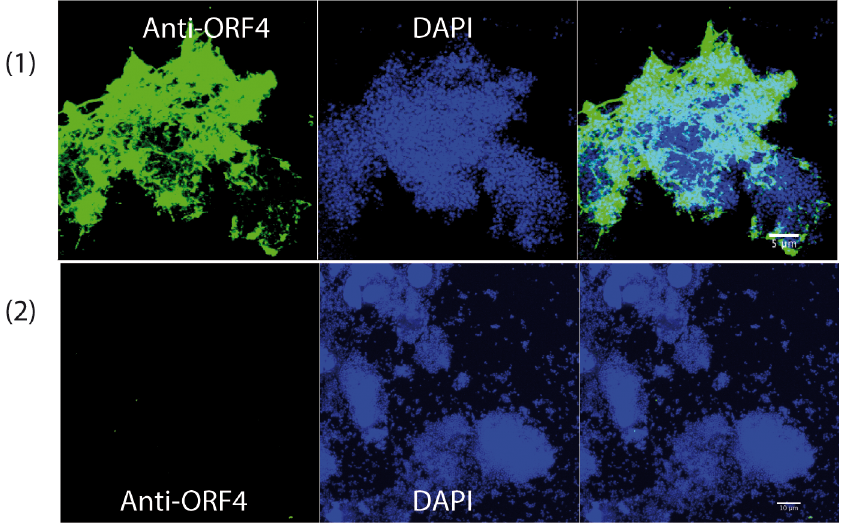
Fig 2. Quantification of MDA Φ in the biomass. Immunofluorescence microscopyperformed on the biomass of bacteria colonizingFaDu cells. Bacteria grown under constant flow were harvested by aspiration from the monolayerof epithelialcells, as describedin the material and methods section. Bacteriophages were labelled(in green) using the polyclonal antibodyanti-MDAORF4 directedagainst the major capsid protein of MDA Φ .Bacteria are stained with DAPI (in blue). (1) Z5463, the green staining which correspond to the bacteriophages represents 75% of the DAPI surface; (2) Z5463 Δ MDA, the green surface is only 0.24% of the DAPI